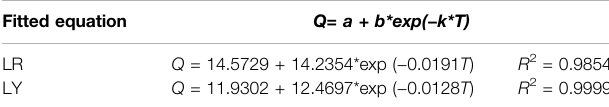
TABLE 2 | Fitting results of coal sample adsorption capacity and temperature at 11 MPa equilibrium